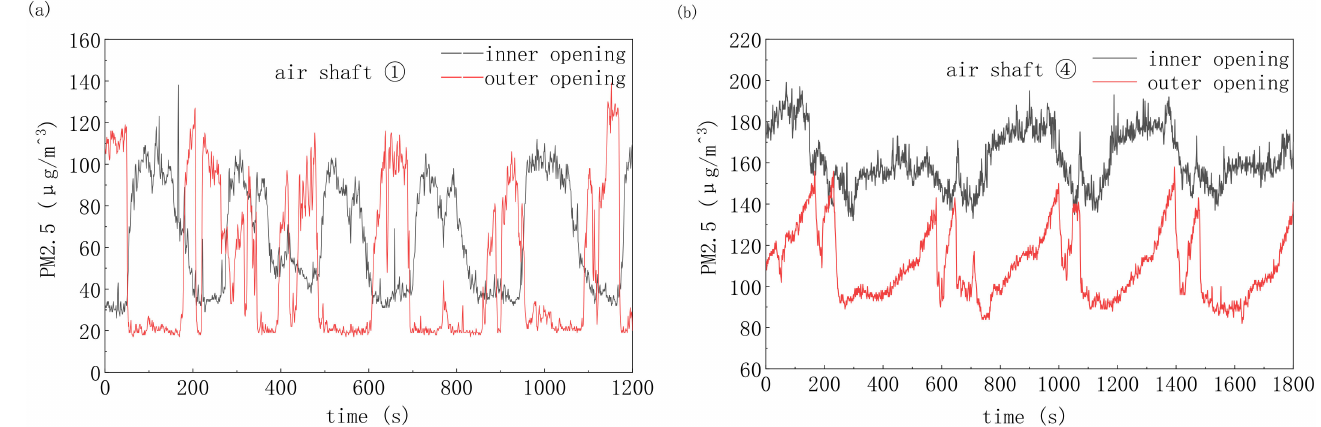
Figure 11. Changes in PM2.5 concentration over time at the inner opening and outer opening of ( a ) air shaft 1 (cid:13) and ( b ) air shaft 4 (cid:13)